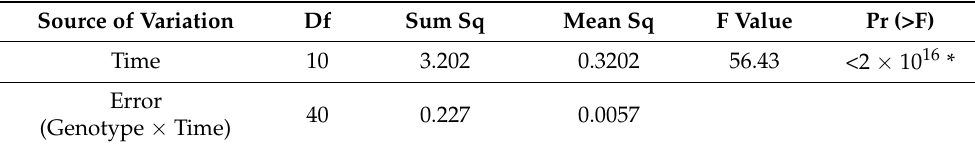
Table 2. Repeated Measure ANOVA for leaf total ODAP content during 2010–2011.